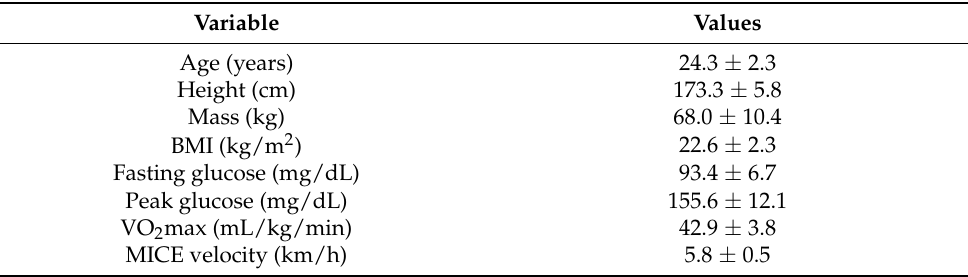
Table 1. Participant